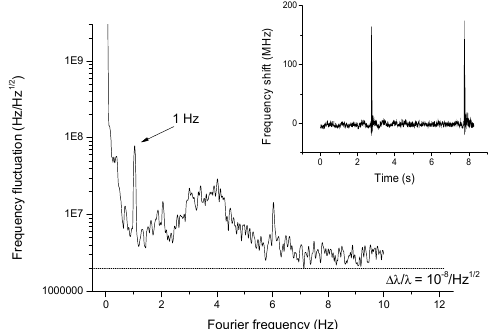
Figure 11. Real-time WGM shift measurements. Noise spectrum of the cavity-laser locking signal with application of a sinusoidal, slow mechanical perturbation. A wavelength-shift resolution limit is extrapolated from the noisefloor (dashed line). In the inset, the response of the droplet to a pulsed perturbation that mimics a particle binding to the surface is shown (All plots are reproduced with permission from [27]).